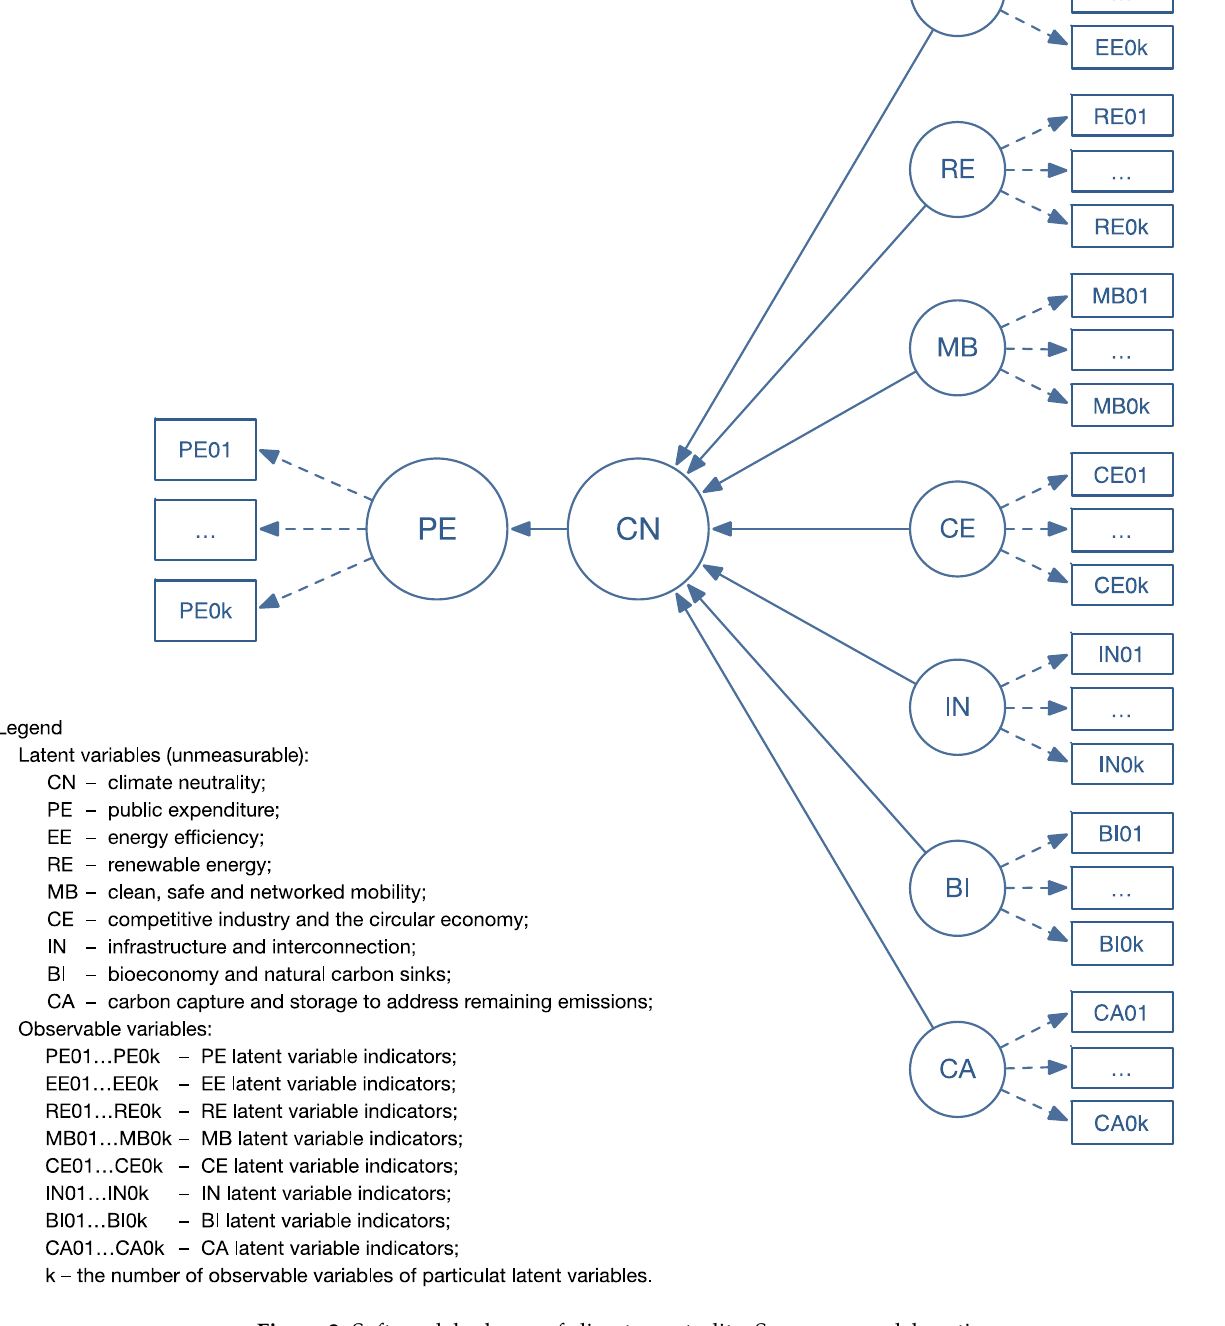
Figure 2. Soft model scheme of climate neutrality. Source: own elaboration. Rank I latent variable PE (public expenditure) was defined on the basis of two indica- tors representing the value and dynamics of the studied phenomenon. Rank I latent variable CN (climate neutrality) was defined on the basis of two comple- mentary indicators revealing, on the one hand, greenhouse gas emission dynamics in 2019 as compared to 2005 and, on the other hand, the participation of afforested areas in total country area, which is the necessary CO 2 absorbent. In order to determine which of the CN fields represented in the theoretical model has a greater impact on climate neutrality, it was also defined by four rank II latent